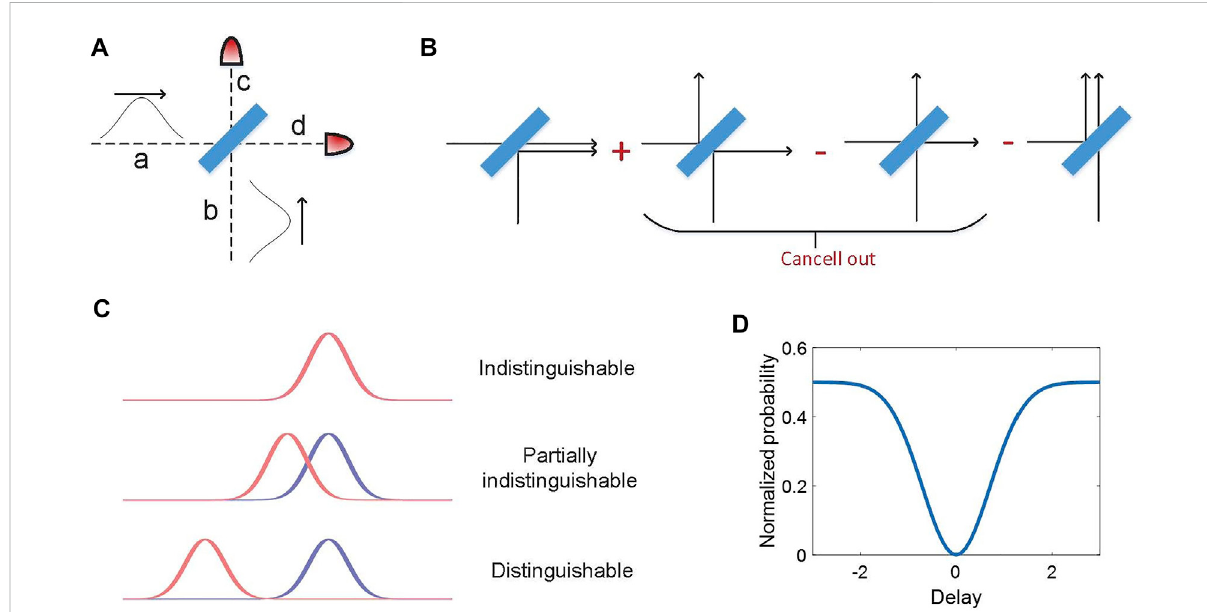
FIGURE 1 (A) Two photons interfere on a beam splitter. After the interaction on the beam splitter, the photons in opposite spatial modes are detected by singlephotondetectors. (B) Diagramshowingfourdifferentcasesfortwophotonstointeractonabalancedbeamsplitter,whereintherelativephase isrevealed bythesigns. If these twophotons arecompletely indistinguishable, thesecond and thirdtermscan becancelled out. (C) Taking temporal distinguishability into consideration, it is allowed to tune the level of distinguishability by changing the time delay between two photons with fi nitebandwidths. (D) The coincidence probability of HOM interference as afunction oftherelativetime delay.Typically, thecoincidencecounts are identi fi ed by using two single-photon detectors at opposite spatial modes c and d, which can be normalized to fi t Eq.